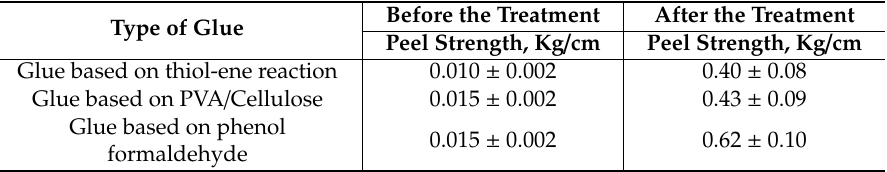
Table 2. T-peel results according to ASTM 1876-01 ( ± standard